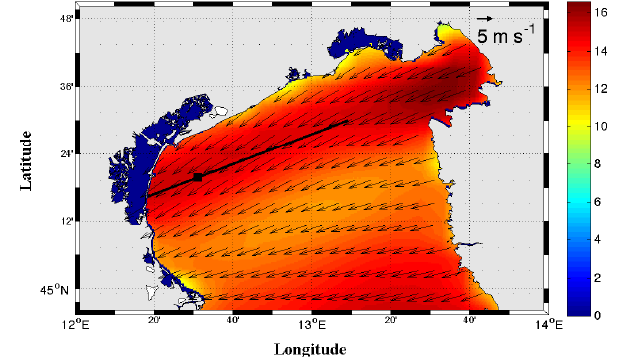
Figure 11. Test-case 1: the 0.07 ◦ BOLAM wind field (black arrow), the WAM B78 wave height field (color filled contour plot) and a tran- sect at the peak of the storm on 29 October. The Venice buoy is also indicated as a black square.